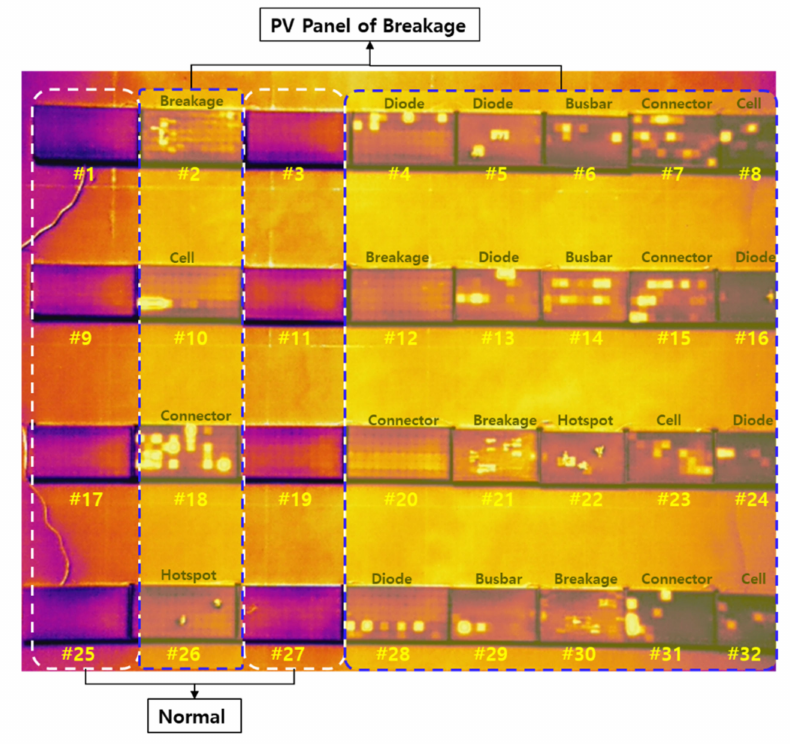
Figure 10. Faulty panel images acquired using a thermal imaging